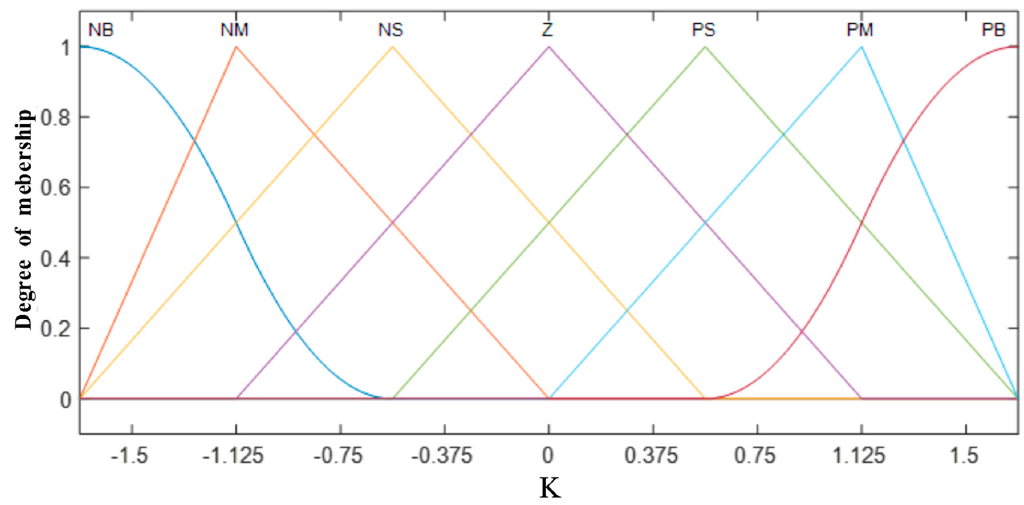
Figure 10. K membership function